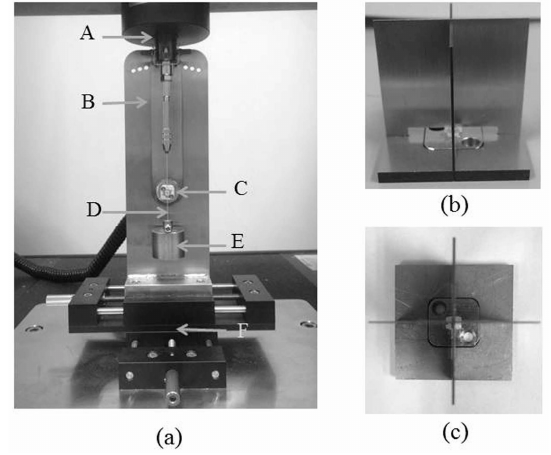
Figure 12. Friction testing systems ( a ) friction-testing device. A: load cell, B: base plate; C: bracket bonded stainless steel plate, D: wire, E: 150-g weight, and F: x-y table. ( b , c ) bracket-mounting